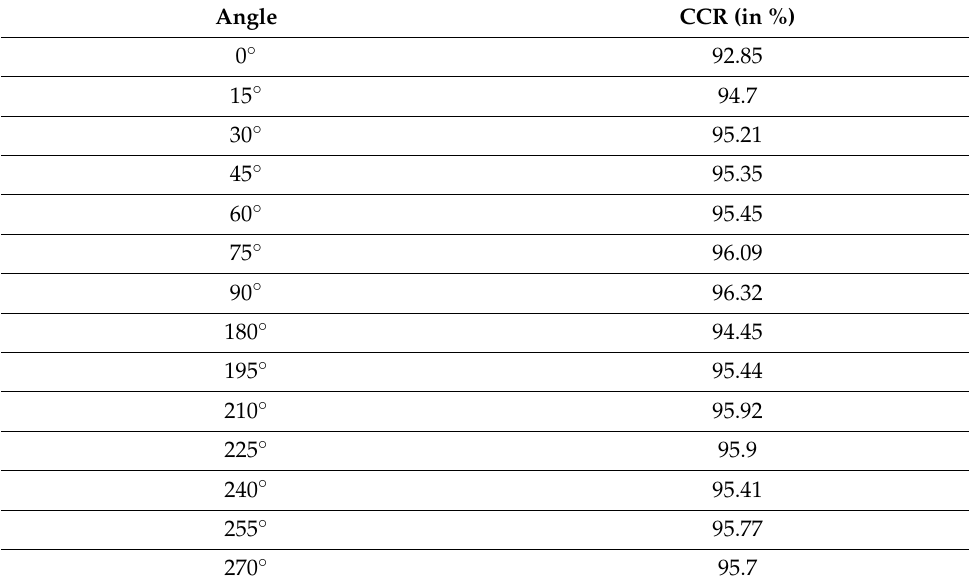
Table 2. CCR for gender classification under each viewing